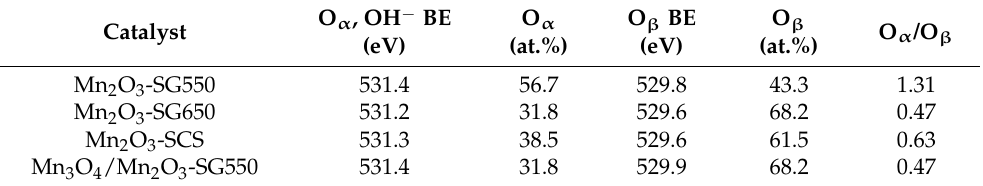
Table 2. Relative percentages (at.%) of oxygen species calculated from the deconvolution of the O 1 s XPS spectra.